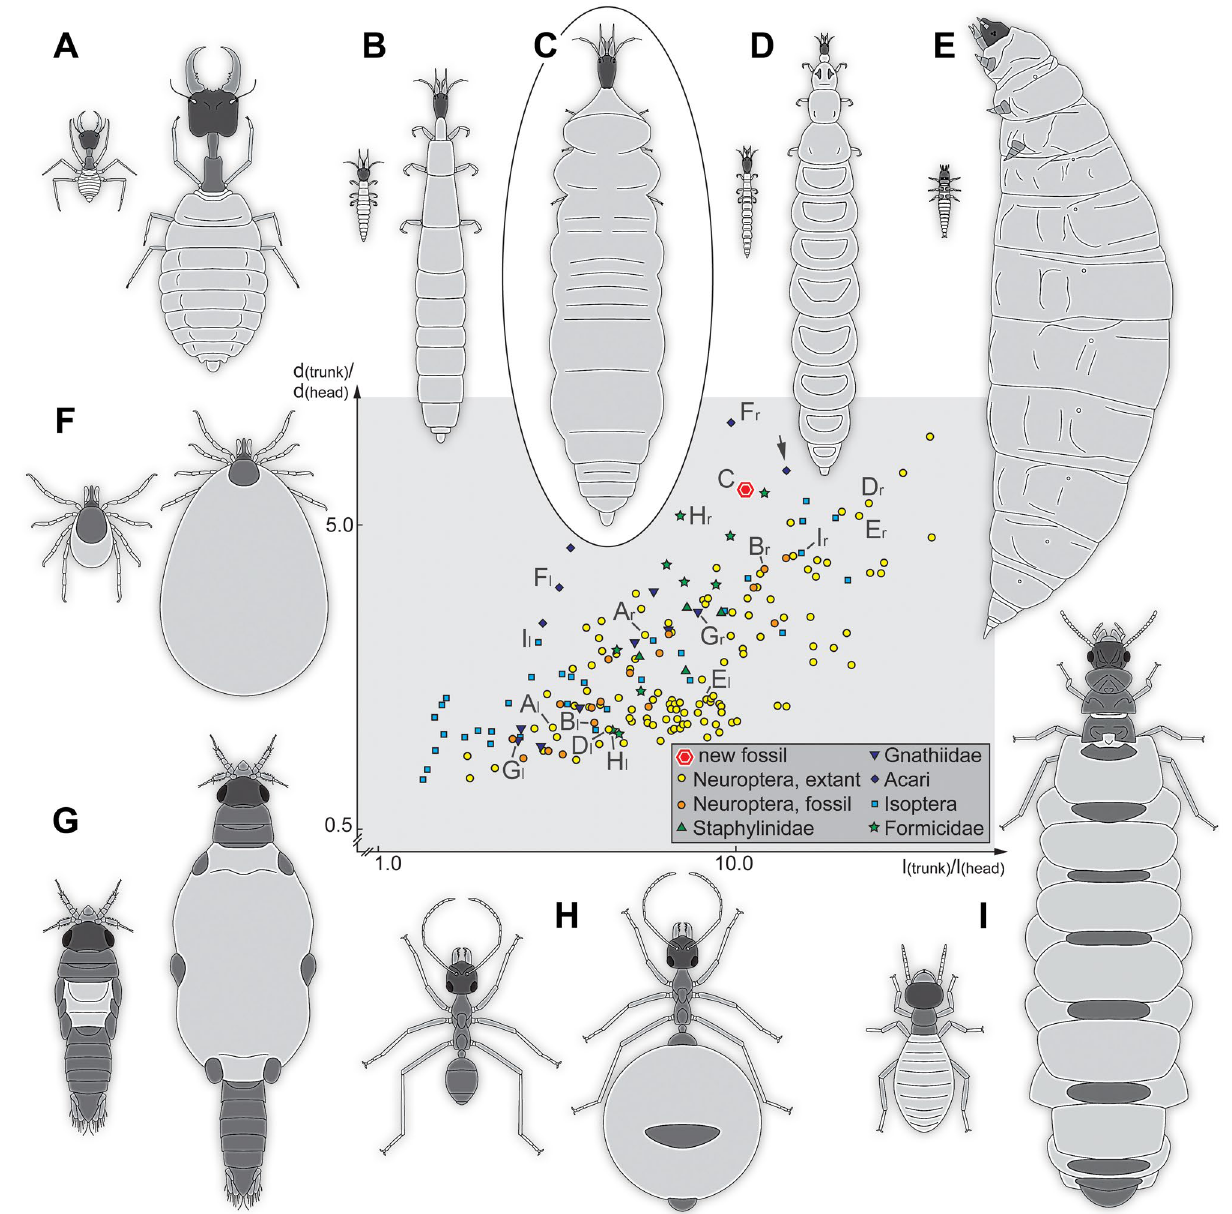
Figure 1. Examples of physogastric/inflated representatives of Euarthropoda and their non-physogastric/non- inflated counterparts and a scatter plot of body ratios (see Supplementary Table 1). The corresponding drawings of the same panel are always to the same scale; note the logarithmic scale; the small letters l and r behind the capital letters refer to the left and right specimen in the respective panel; the arrow marks the fossil physogastric tick reported by Peñalver et al. 17 . ( A–E ) Lacewing larvae. ( A ) Thread-winged lacewings (Crocinae), Josandreva sazi 18 , larva stage 1 (left) and 3 (right). ( B ) Fossils of possible beaded lacewings (Berothidae 19 ), possible larva stage 1 (left, specimen 5835, CJW F 3198) and possible larva stage 3 (right, specimen 5833, CJW F 3197). ( C ) New fossil larva. ( D ) Beaded lacewings, Lomamyia 20 , larva stage 1 (left) and 3 (right). ( E ) Mantis lacewings (Mantispidae), Mantispa uhleri 21 , larva stage 1 (left) and 3 (right). ( F ) Ticks (Acari 9 ), unfed female (left) and fed female (right). ( G ) Gnathiidae, Gnathia africana 22 , unfed zuphea (left) and fed praniza (right). ( H ) Honey-pot ant (Formicidae), Myrmecocystus mexicanus “normal” worker (left, bugguide #1588835) and worker in honey- pot state (right, bugguide #567398). ( I ) Termites (Isopoda), Macrotermes gilvus 13 , worker (left) and physogastric queen (right). d(head) diameter of head, d(trunk) diameter of trunk, l(head) length of head, l(trunk) length of